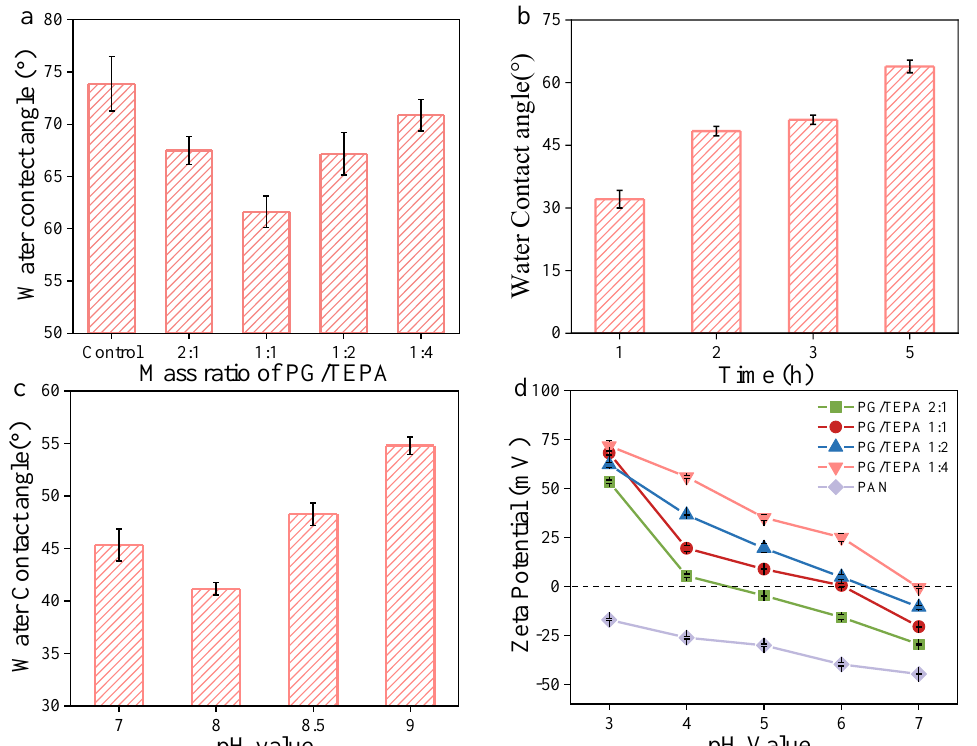
Figure 6. Surface properties of PG/TEPA membrane: ( a ) water contact angles of PG/TEPA mem- branes with different mass ratios of PG/TEPA (control means the PAN UF membrane, the effect of different ratios on WCA is explored under the 2 h reaction time and pH 8.5); ( b ) water contact angles of the PG/TEPA membranes with different reaction times (the effect of reaction times on WAC is explored with a constant PG/TEPA ratio of 1:1 and a pH of 8.5); ( c ) pH values of buffer solutions (the effect of pH on WCA is explored with a constant PG/TEPA = 1:1 and a reaction time of 2 h); and ( d ) zeta potential of PAN UF membrane and PG/TEPA NF membranes with different PG and TEPA mass ratios (the effect of different ratios on ζ potential is explored with a reaction time of 2 h and the pH of 8.5).